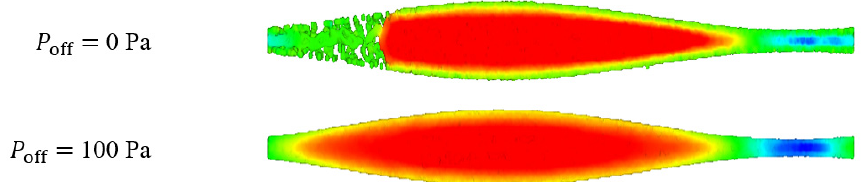
Figure 4. Addition of a background pressure is used to prevent void formation. The contours show velocity, but the key point is the breakup of the fluid in the top picture is avoided when the offset pressure is present.